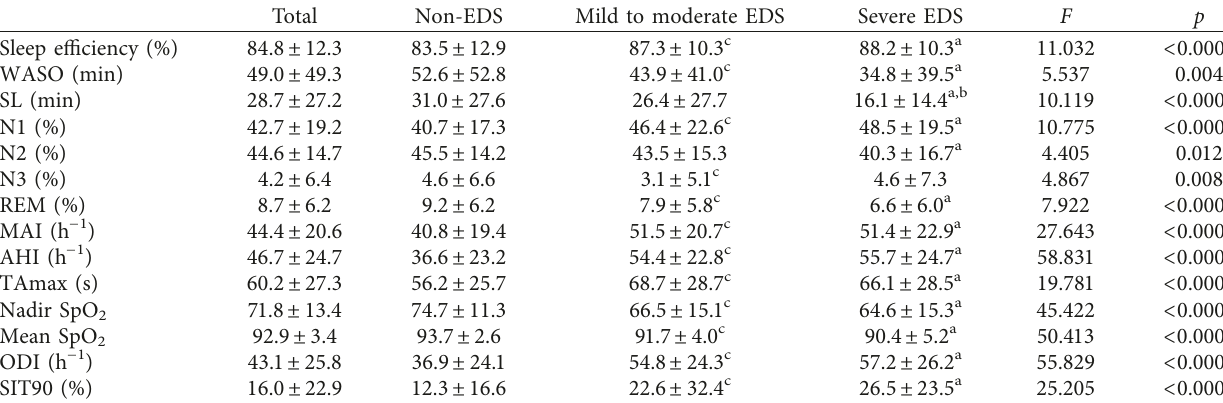
Table 3: PSG variables of the total OSA patients and the patients with different severities of EDS. Total